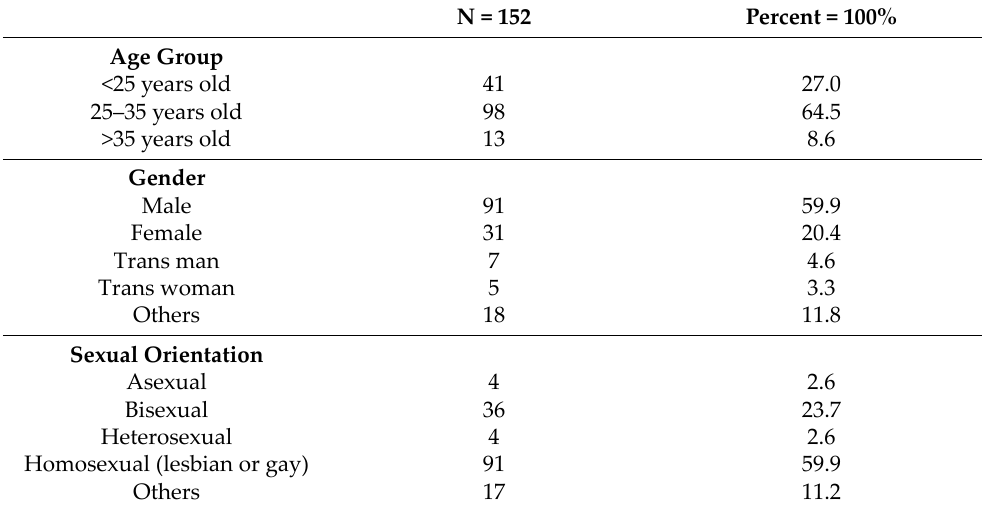
Table 1. Sociodemographic data and coping skills among the LGBT+ community in